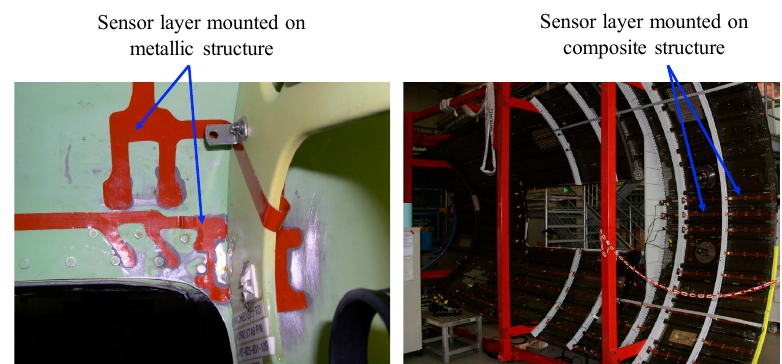
Figure 3. Sensor layers mounted on the surfaces of metallic and composite structures.